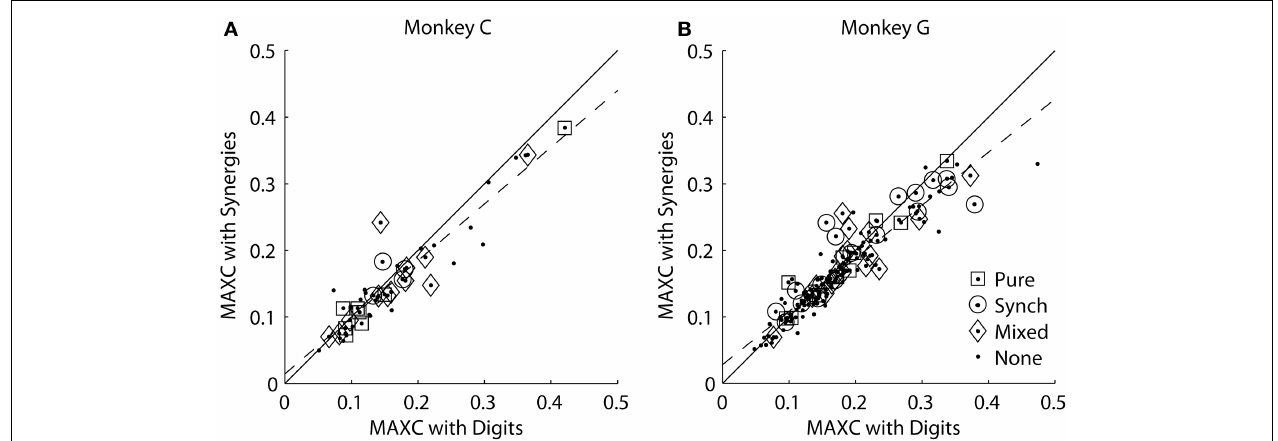
the average kinematic synergies from that monkey (ordinate).The solid line has a slope of 1.0, and the dashed line is the linear regression best fit to the data. Open symbols indicate the points representing neurons that had different types of effects in spike-triggered averages of EMG as indicated by the legend.